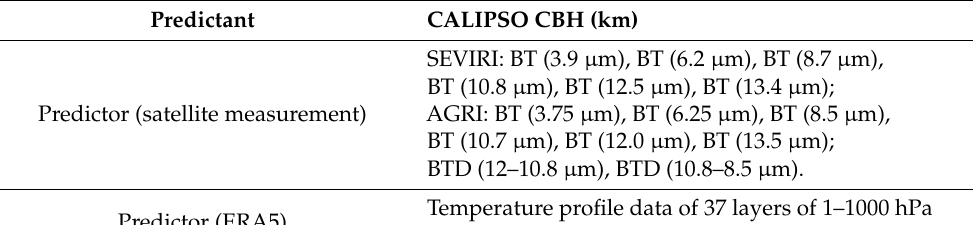
Table 3. Predictant and predictor variables used for regression model training and prediction for different ML methods.